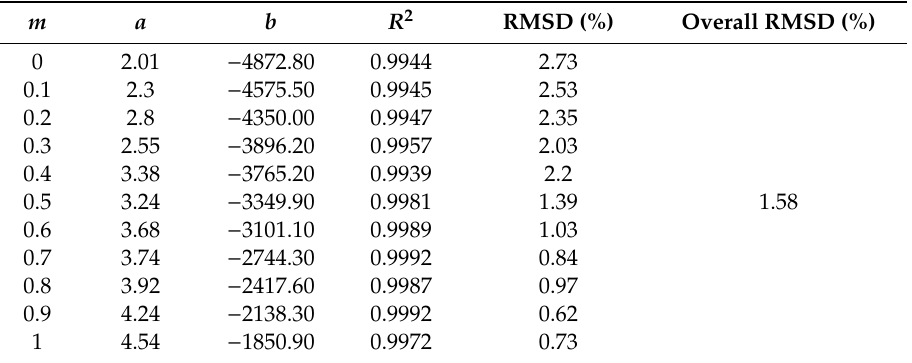
Table 5. The parameters of van’t Ho ff model ( a and b ) along with R 2 and root mean square deviations (% RMSDs) for FFA in various Carbitol + water combinations ( m ) c